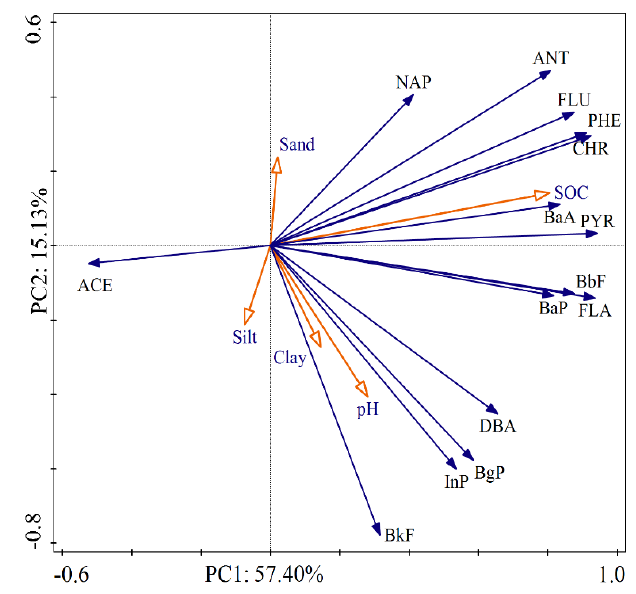
Figure 4. Principal component analysis (PCA) of the correlation between PAHs and soil physicochemical properties. All the PAHs abbreviations used are explained in Supplementary Table S1.